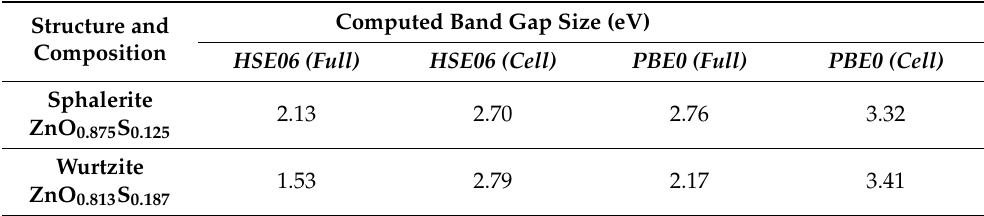
(full) and “cell” relaxed with high symmetry (cell)